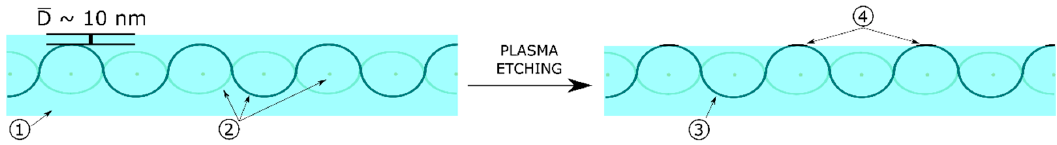
Figure 2. Schematic sketch of plasma etching. The average thickness of the etched polymer over the wire tops was about 10 nm. 1—polymer foil; 2—mesh of polymer and metal wires; 3—metal wire; 4—uncovered metal wires tops.